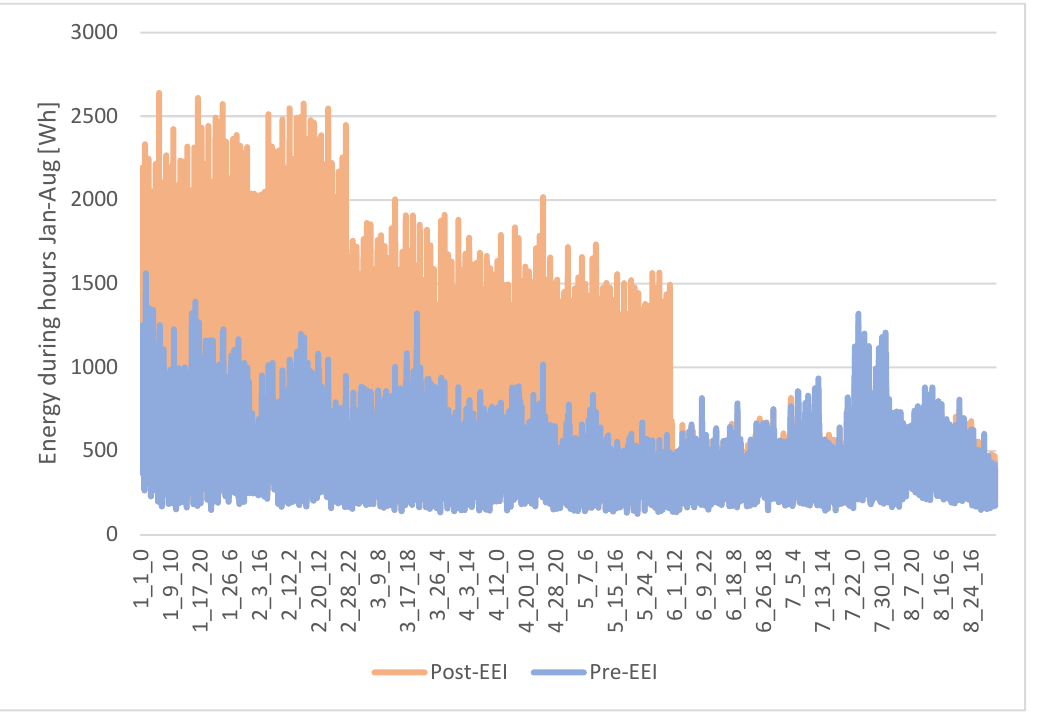
Figure 2. Comparison of pre- and postintervention (HP + TI): load profile.